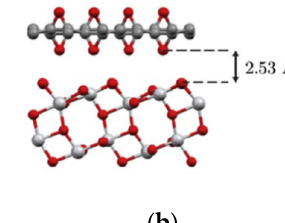
Figure 8. Decomposition of N 2 O over an anatase (001) surface containing an oxygen vacancy. Reproduced with permission from Reference [89]; copyright (2018) The Royal Society of Chemistry.